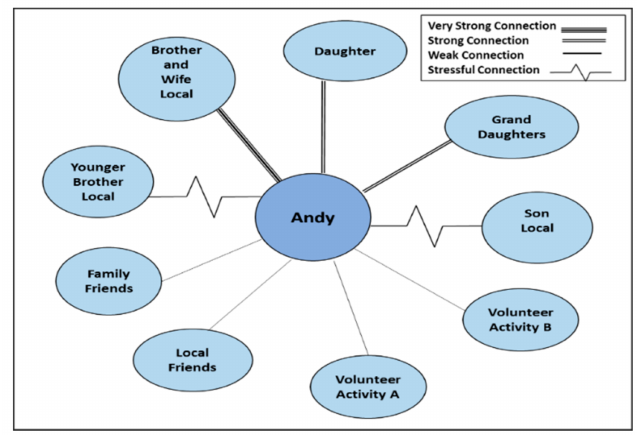
Figure 1. Restricted Family Dependent Network, Andy